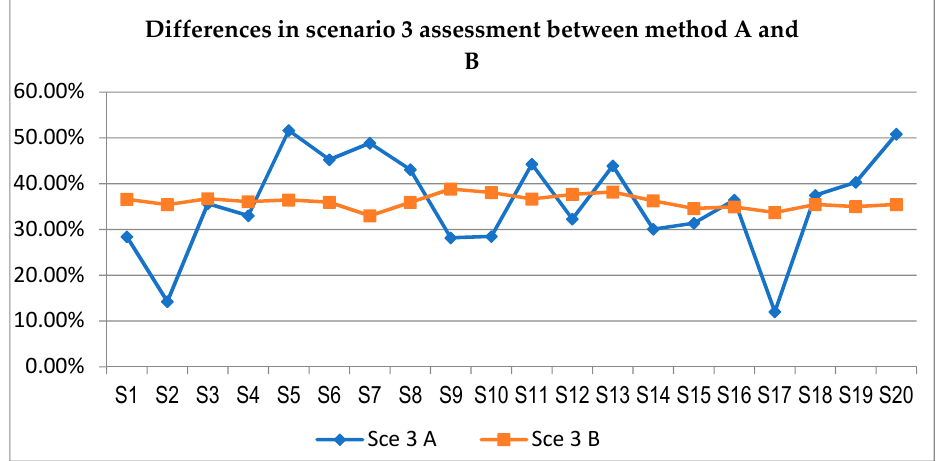
Figure 11. Differences in scenario 3 assessment between multi-actor multi-criteria analysis (method A) and multi-actor multi-criteria analysis with the weight of stakeholder involvement (method B).